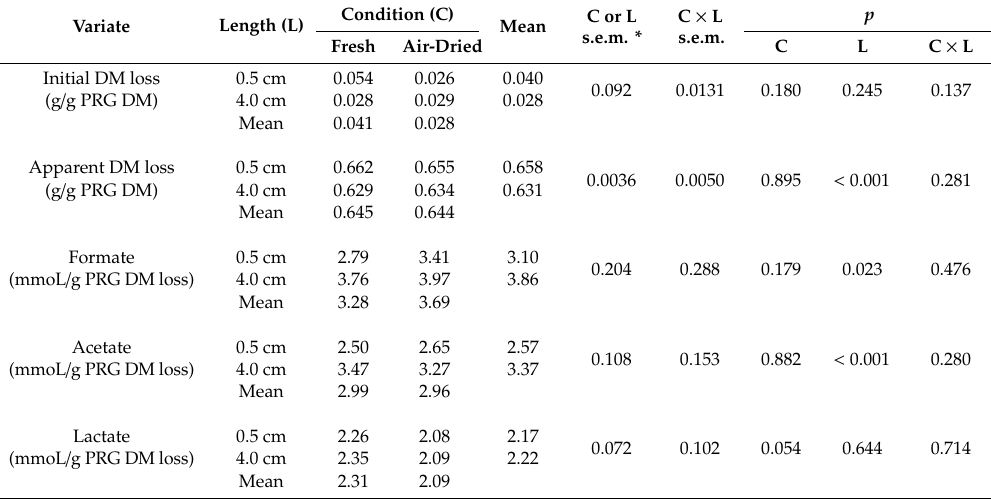
Figure 4. E ff ect of leaf-blade cut-length (0.5 or 4.0 cm) and forage condition (fresh or air-dried) on cumulative gas production by N. frontalis fermentation of perennial ryegrass (PRG). The plot is a representation of the fitted profiles generated using the model of France et al. [20]. Symbols represent mean net volumes for four replicated bottles of fresh or air-dried leaf-blades of di ff ering cut-lengths as identified in the figure. Time since leaf-blade addition is relative to the start of leaf-blade additions for each treatment. Table 4. E ff ect of perennial ryegrass (PRG) leaf-blade condition (fresh or air-dried) on initial and apparent dry matter (DM) loss, and production of aqueous fermentation end-products by N. frontalis at two di ff erent leaf-blade